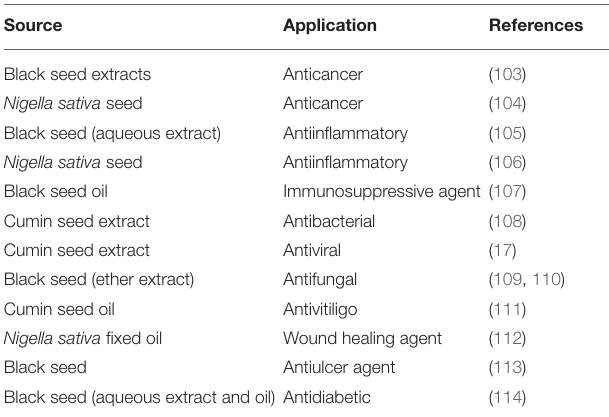
TABLE 5 | Application of bioactive compounds obtained from black seed and its by-products in the pharmaceutical